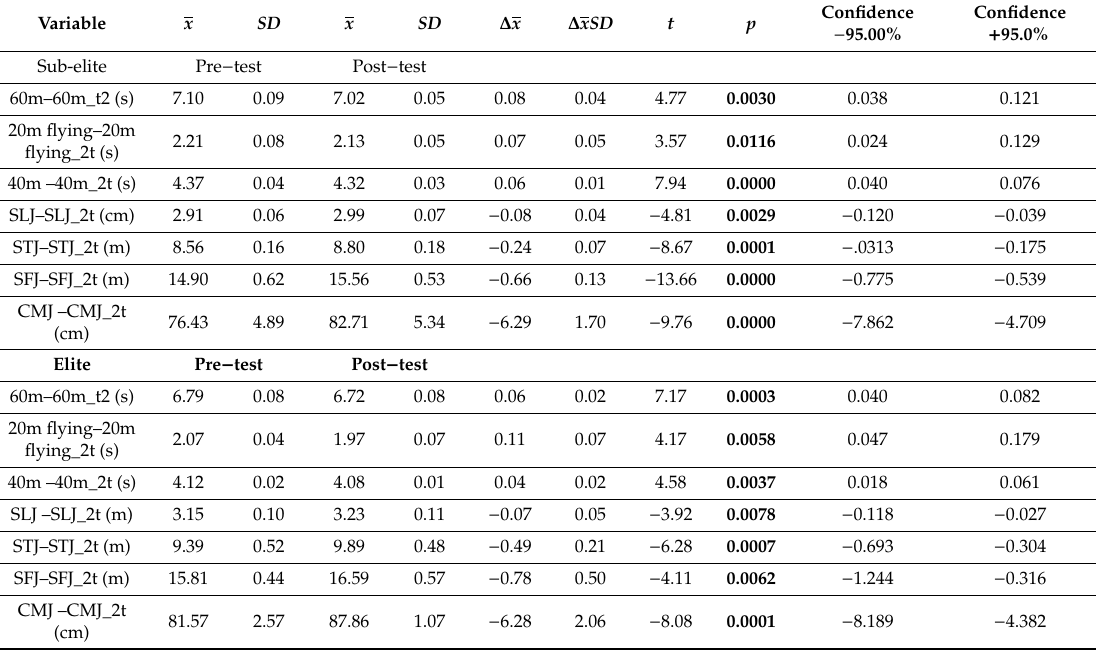
Table 4. Student’s t test results for the dependent